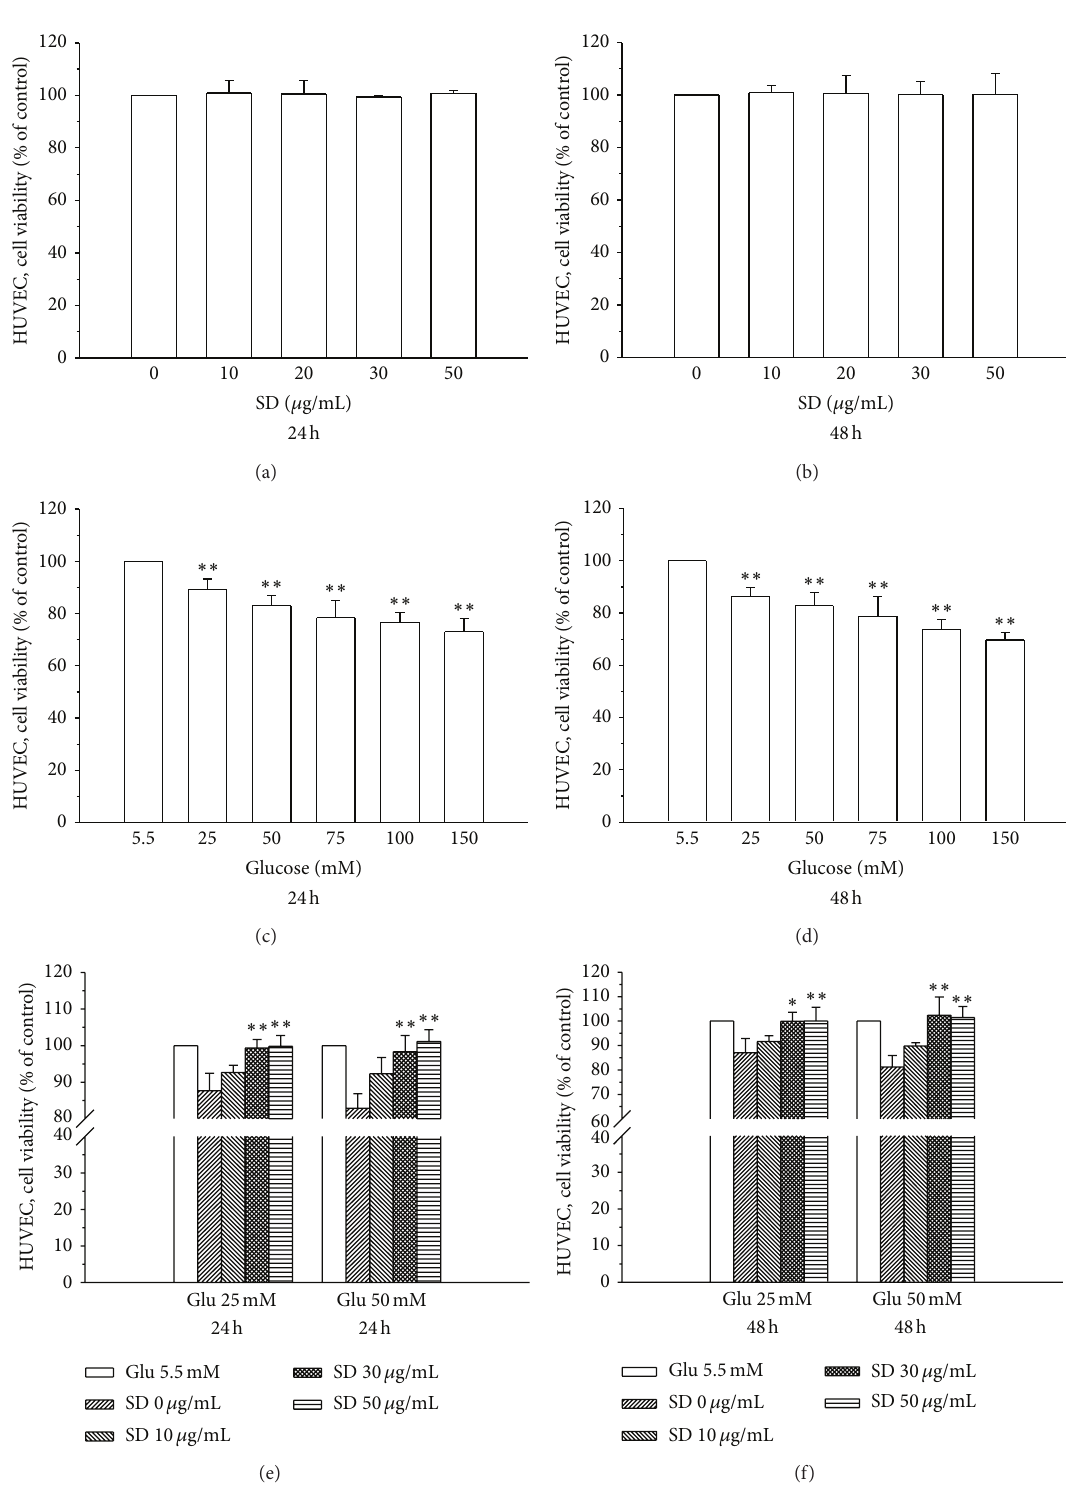
Figure 1: Effects of SD on the cell viability of human umbilical vein endothelial cells (HUVEC): ((a), (b)) the viability of HUVECs during treatment with various concentrations (10–50 𝜇 g/mL) of SD for 24 and 48 h; ((c), (d)) the viability of HUVECs during treatment with various concentrations (25–150mM) of glucose for 24 and 48h; ((e), (f)) the viability of HUVECs upon treatment with various concentrations (0– 50 𝜇 g/mL) of SD in glucose-induced (25 and 50mM) HUVECs for 24 and 48 h. Data are shown as the mean ± SEM of three independent experiments. ∗ 𝑃 < 0.05 ; ∗∗ 𝑃 < 0.01 , compared with the glucose treated